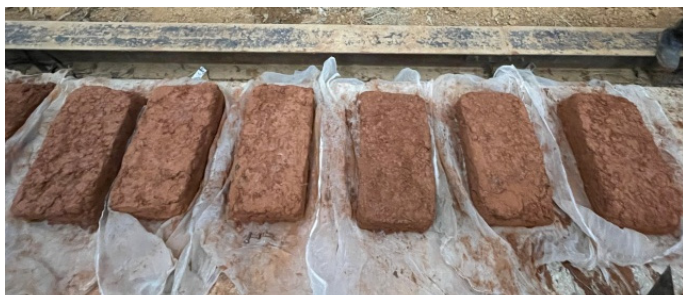
Figure 8. Samples of potato-soil mixture.